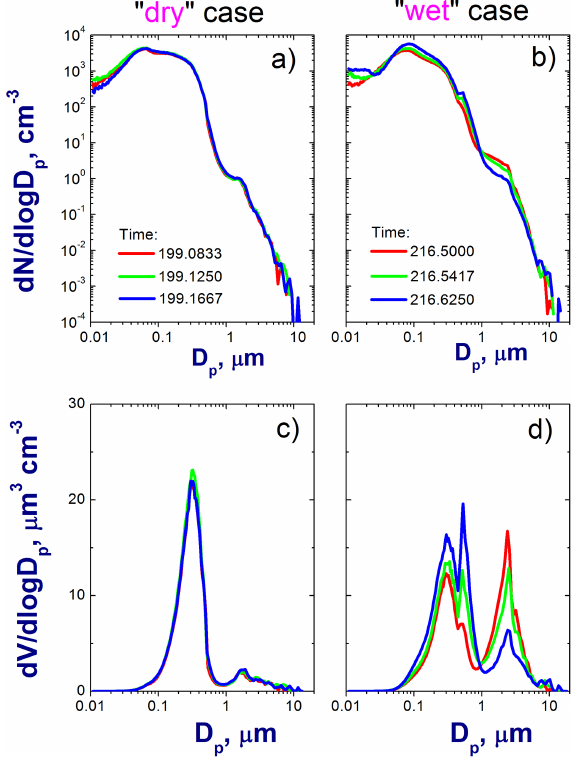
Figure 8. Particle number (top row) and volume (bottom row) size distributions obtained from the retrieved effective density ( ρ mod ) and the measured SMPS and APS spectra. Red, green, and blue colors are used for different time steps within specified sub-periods (Appendix B). These sub-periods represent cases with similar opti- cal properties but very different values of the instrument RH. For the first sub-period (dry case; left column), the RH is relatively small (RH ∼ 45%). For the second sub-period (wet case; right column), the RH is relatively high (RH ∼